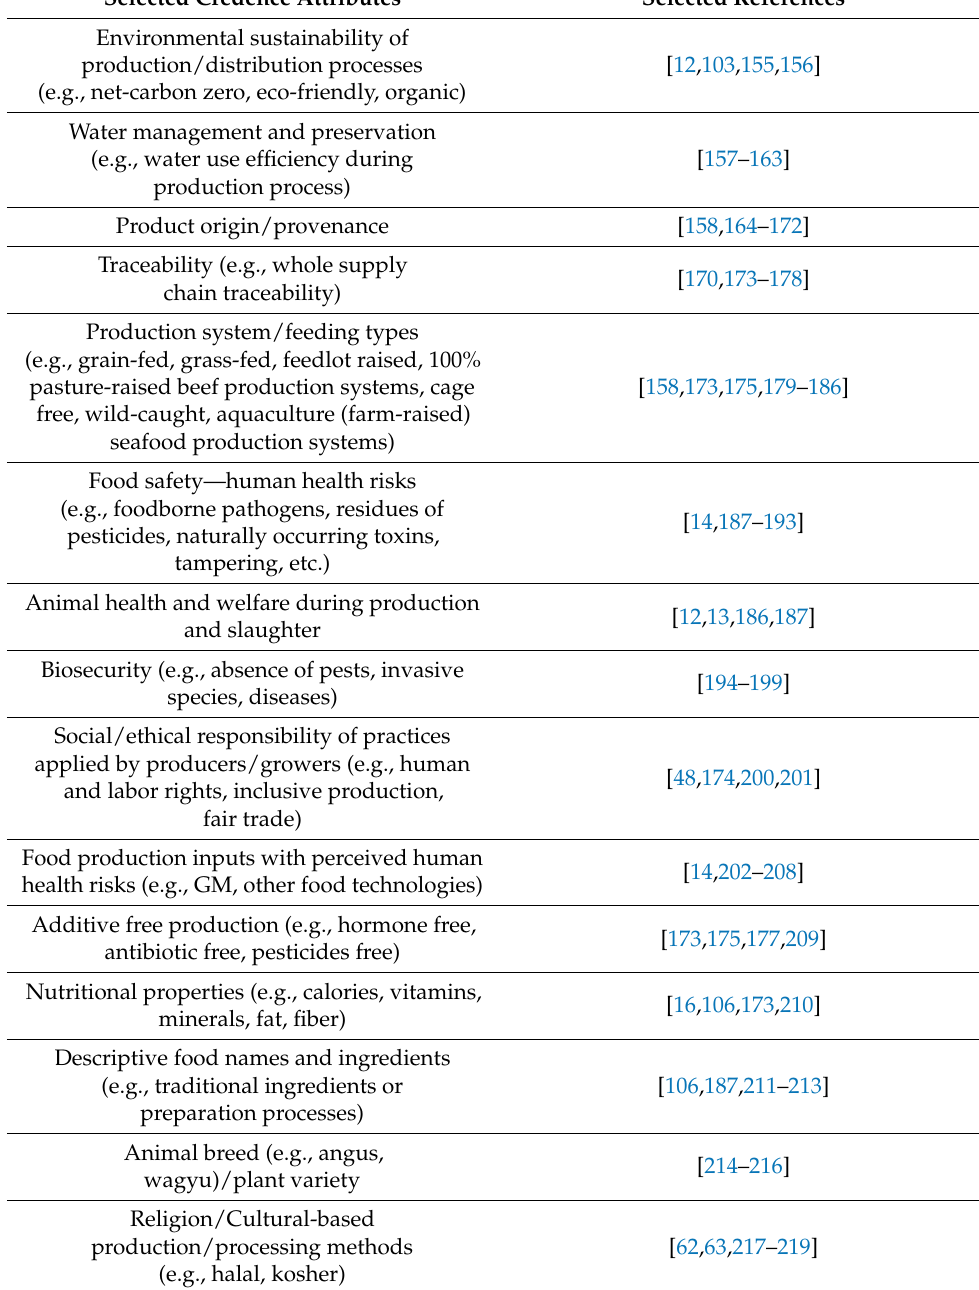
Table A1. Current key agri-food credence